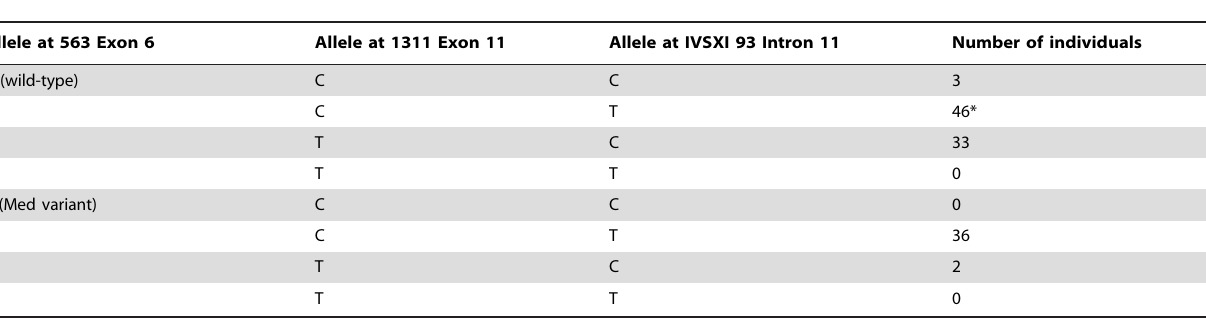
Table 3. Frequency of 1311C . T/IVSXI C93T haplotypes according to allele at 563C . T